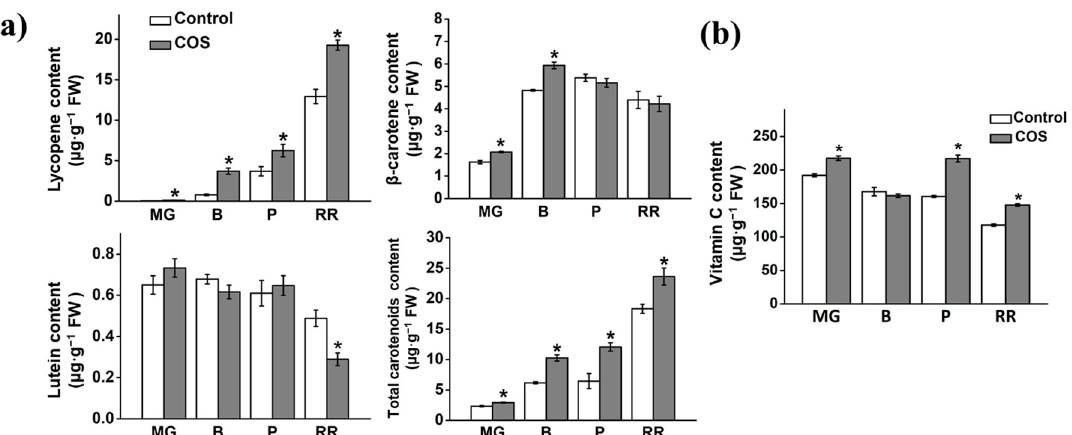
Figure 3. Effect of COS on the health-promoting compounds in tomato fruits. ( a ) The effect of COS on carotenoid composition and content. ( b ) The effect of COS on vitamin C content. Data represent the means ± SD of three biological replicates. The asterisk represents a significant difference compared with the control based on Student’s t -test (* p < 0.05). MG: mature green; B: breaker; P: pink; RR: red ripened. FW: fresh weight.